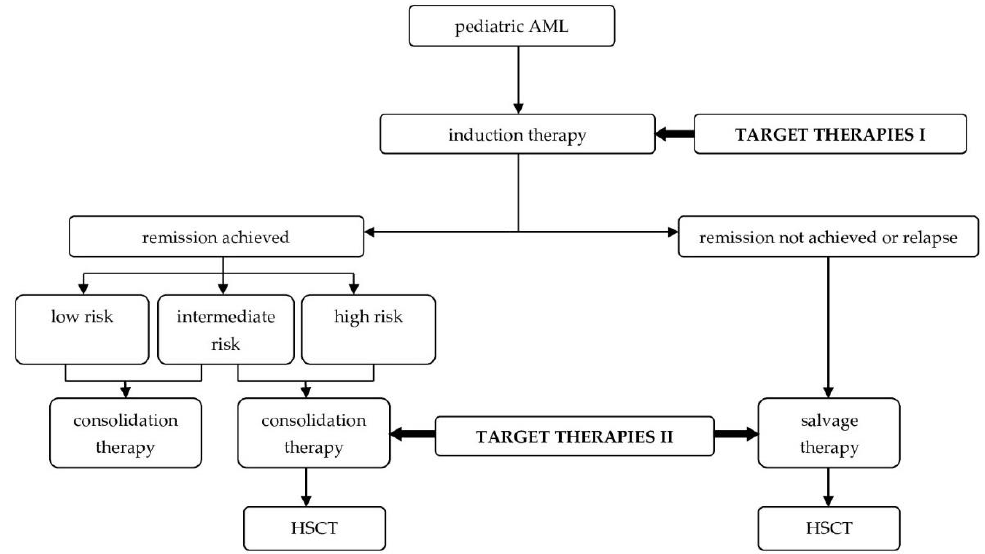
Figure 3. Place of novel AML therapies in the treatment algorithm. Target Therapies I include: Gemtuzumab ozogamicin, midostaurin, sorafenib, venetoclax, azacitidine, decitabine, panobinostat and CAR-T. Target Therapies II include: midostaurin, gilteritinib, venetoclax, azacitidine, decitabine, pracinostat, panobinostat and Camidanlumab tesrine.